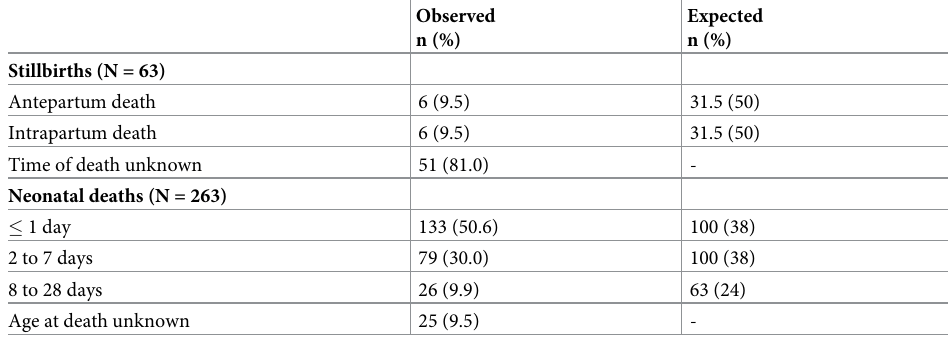
Table 1. Stillbirths and neonatal deaths identified using PN RAPID in two facilities in